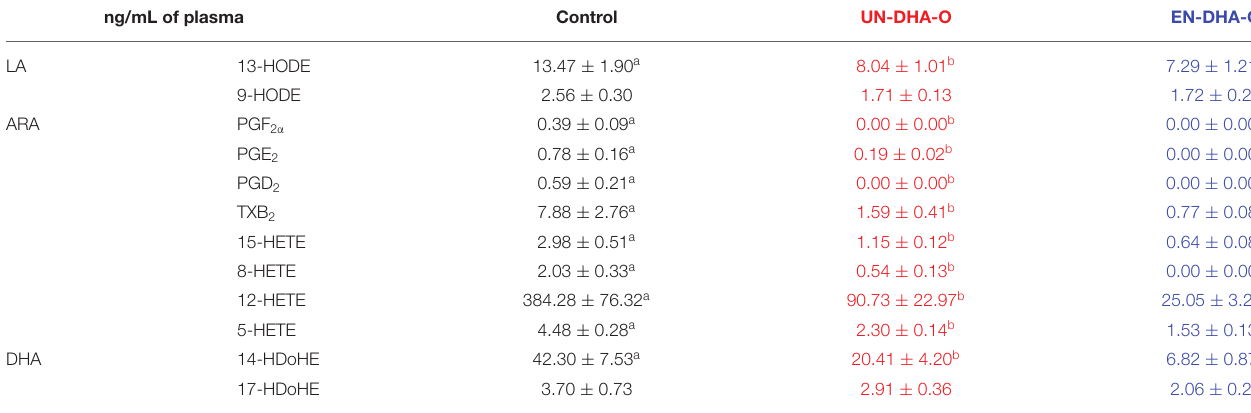
TABLE 6 | The oxidized derivatives of fatty acids from plasma. ng/mL of plasma